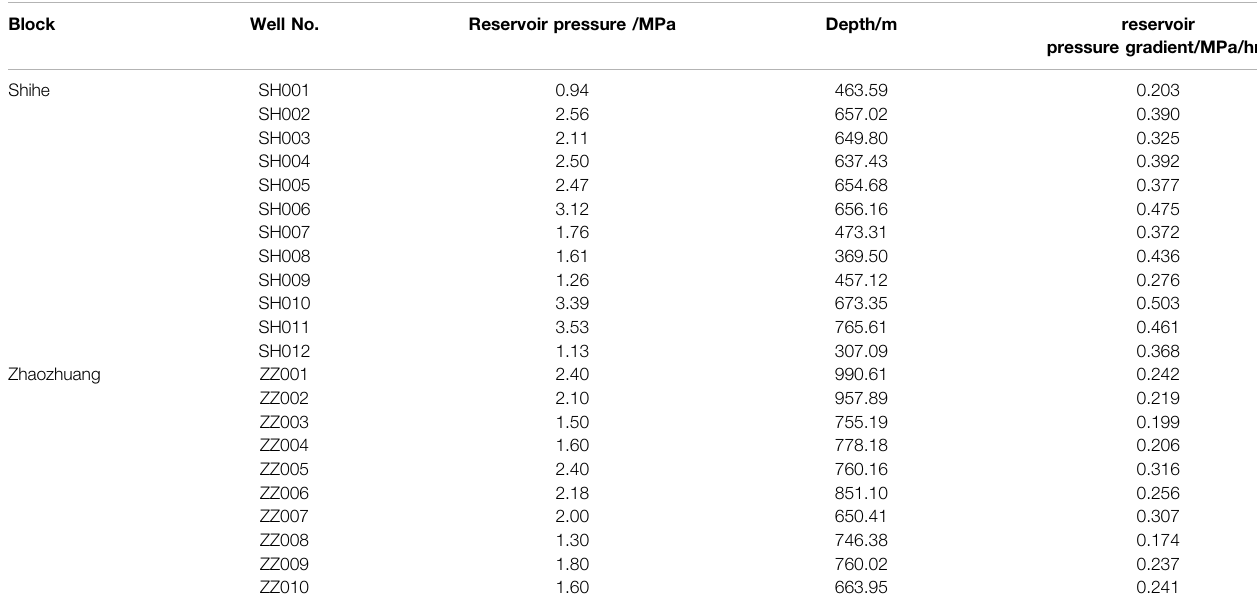
TABLE 5 | Reservoir pressure data of No.3 coal seam. Block Well No. Reservoir pressure /MPa Depth/m reservoir